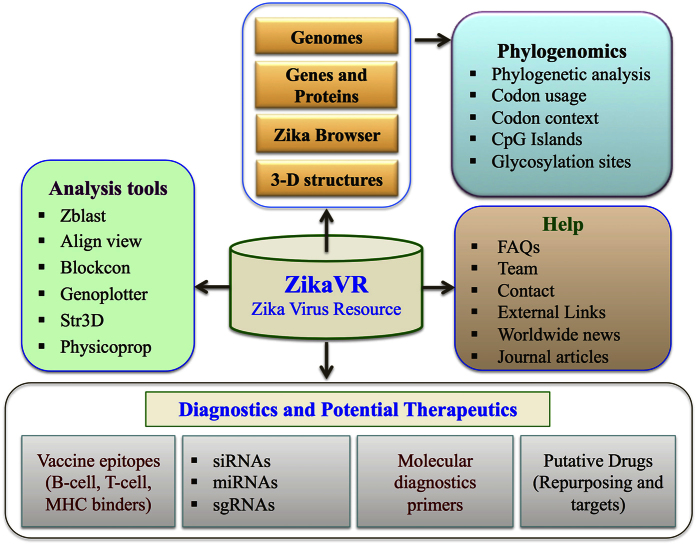
ZikaVR overview.